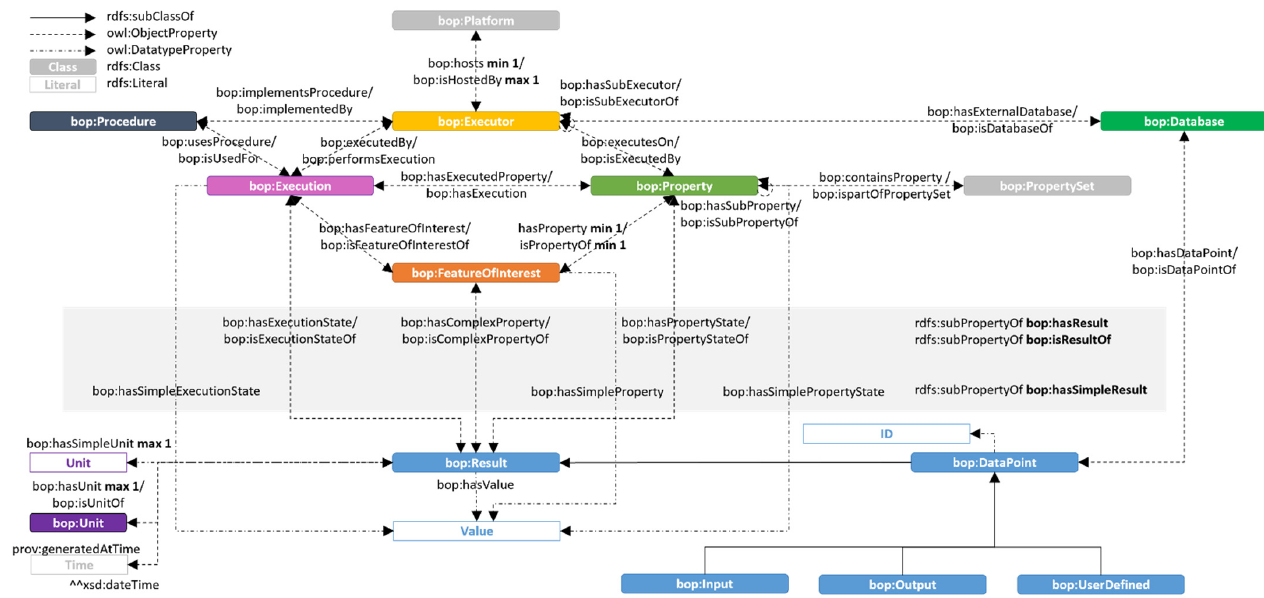
Legend. Property, Feature of interest, Executor, Execution, Procedure, Result, Unit, Database, Other. Figure 21. The Building Performance Ontology’s upper ontology. Figure 21. The Building Performance Ontology’s upper